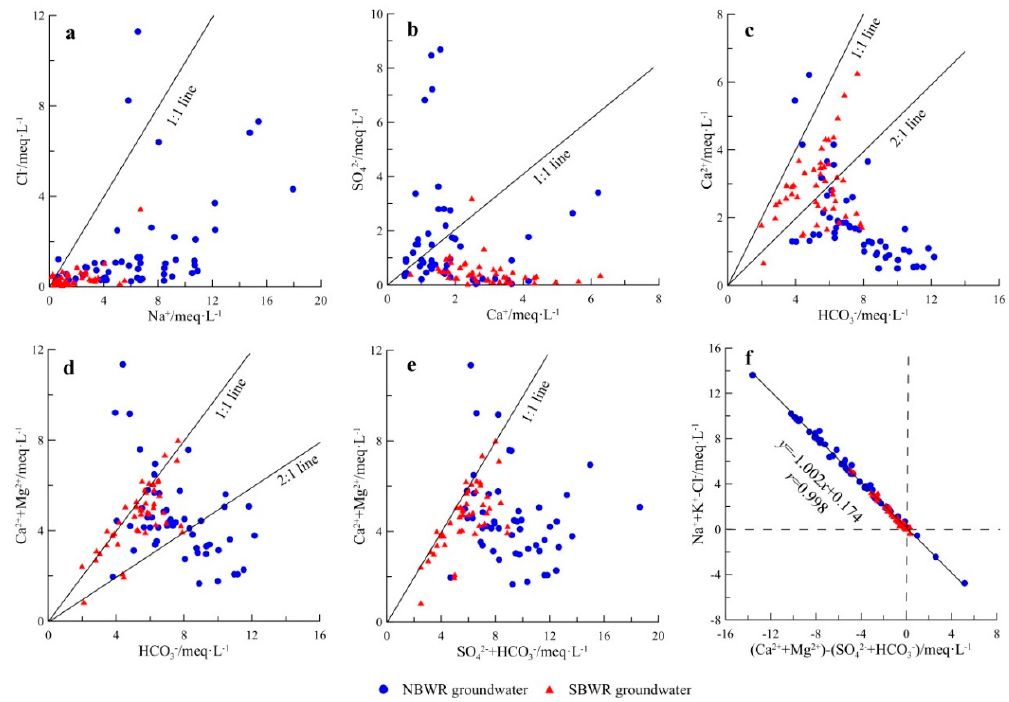
Figure 4. Bivariate diagrams of major ionic concentrations in groundwater samples ( a ): Cl - vs. Na + ; ( b ): SO 42- vs. Ca 2 + ; ( c ): HCO 3 − vs. Ca 2 + ; ( d ): HCO 3 − vs. Ca 2 + + Mg 2 + ; ( e ): HCO 3 − + SO 42 − vs. Ca 2 + + Mg 2 + ; ( f ): Na + + K + − Cl − vs. (Ca 2 + + Mg 2 + ) − (HCO 3 − + SO 42 −